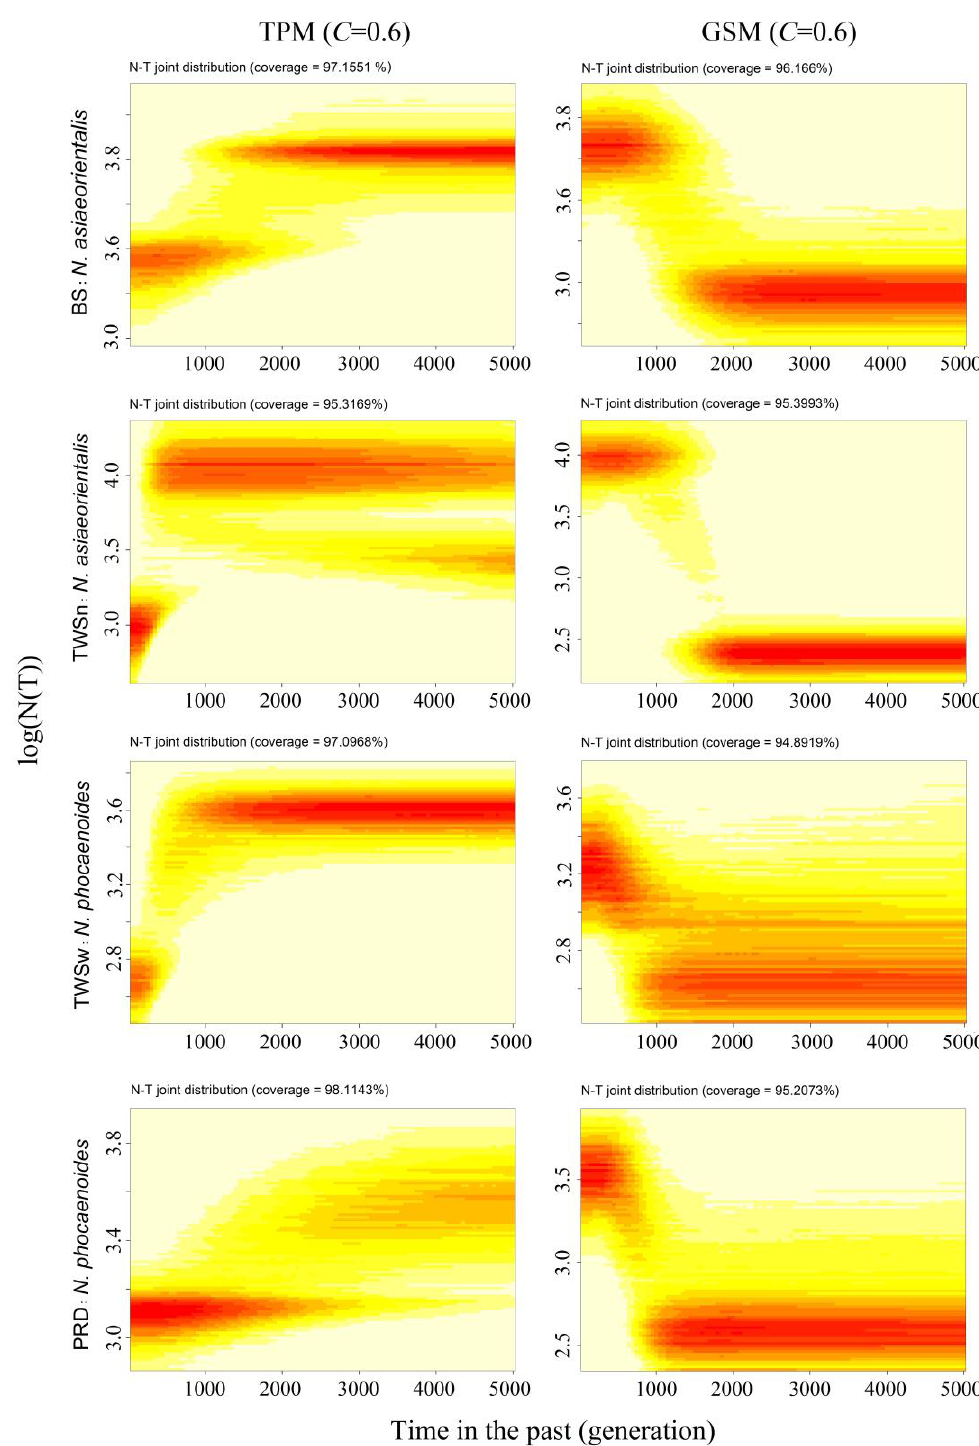
Figure 3. The joint posterior distribution for the effective population size (logN T ) at time T under the two-phase mutation model (TPM; left panel ) and the generalized stepwise mutation model (GSM; right panel ) with a large proportion of multi-step mutation (C = 0.6), with time scaled in generations of the specific population.